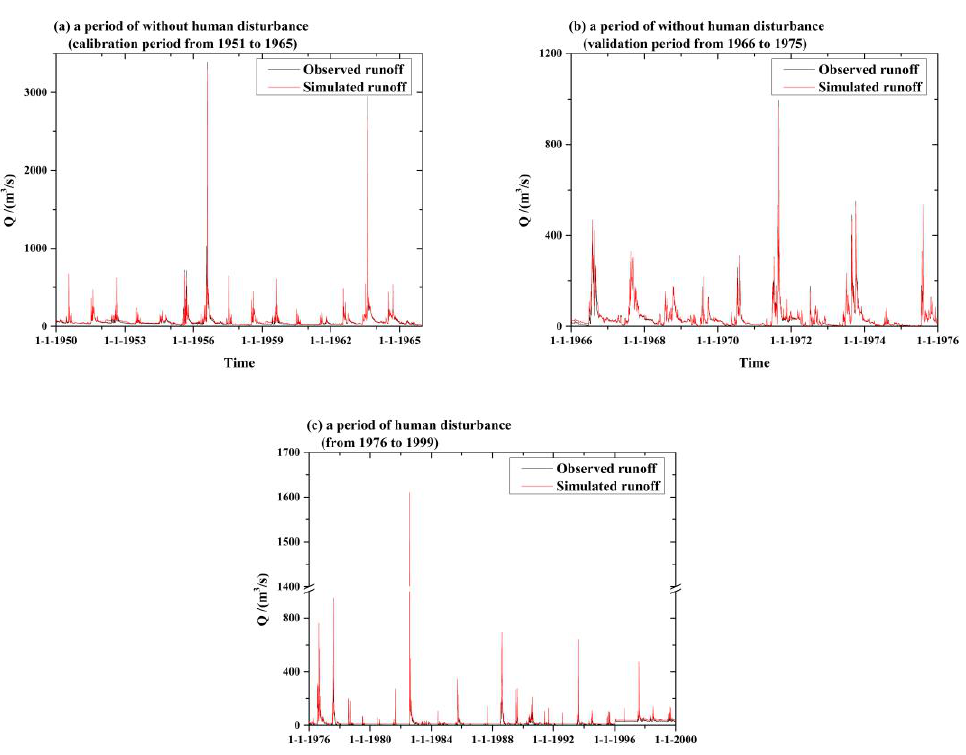
Figure 6. Mann-Kendall abrupt change point test of runoff at the Guantai Station.